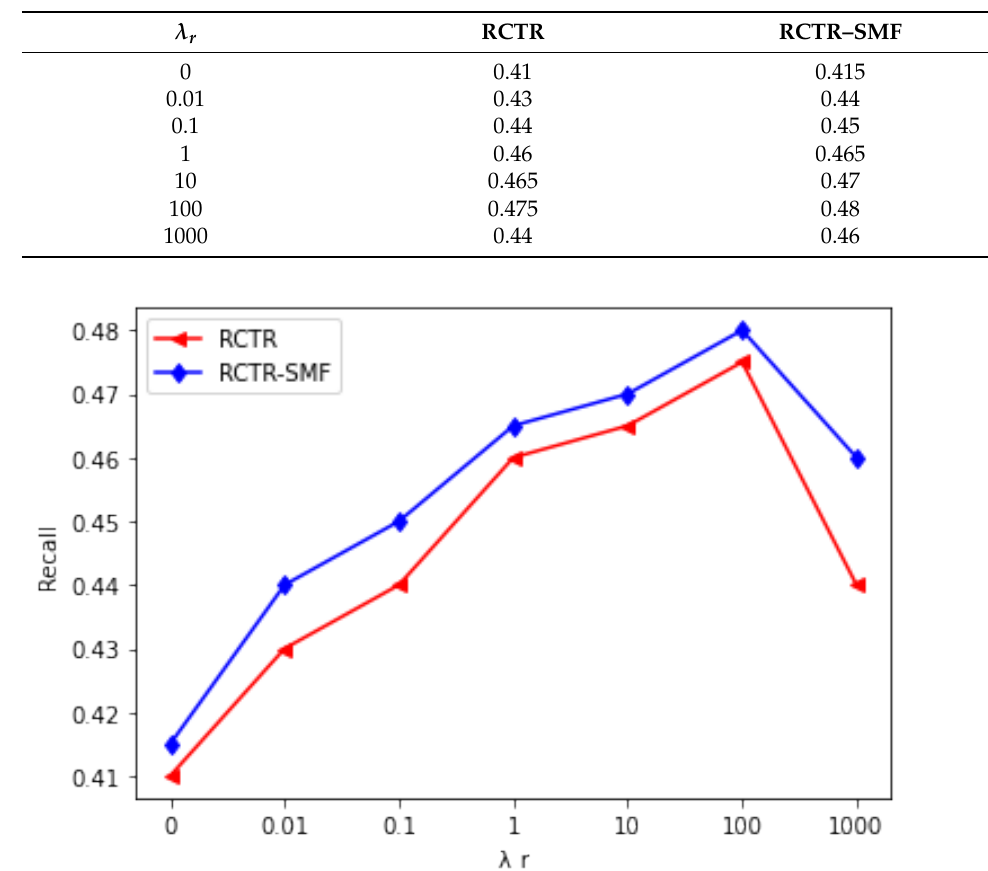
Figure 7. Recall Comparison of RCTR and RCTR–SMF when λ r is varied, but λ v and λ q are constant @ M = 300.